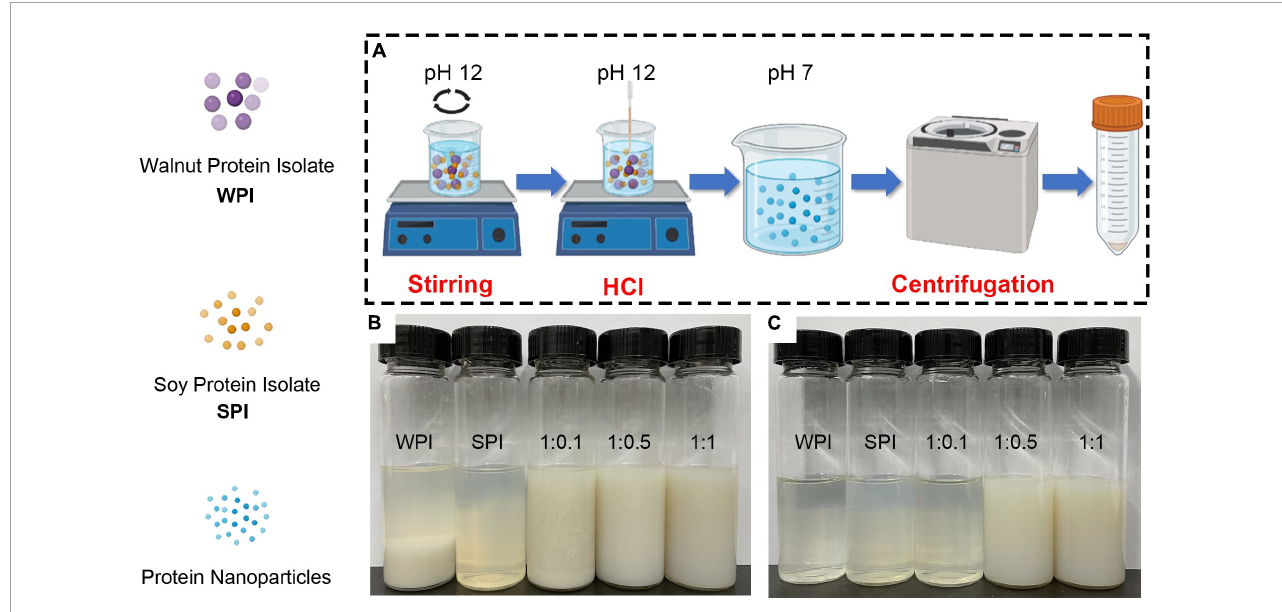
FIGURE1 (A) Schematic illustration of the pH-cycle technique for fabricating protein-based composite nanoparticles with hydrophobic WPI and hydrophilic SPI. (B) Photographs of protein solutions and composite nanoparticles after the pH-cycle treatment. (C) Photographs of sample supernatants by centrifuging at 10,000 × g and 4 ◦ C for 20 min (1:0.1, 1:0.5, 1:1 represents walnut protein and soy protein isolate at the ratio of WPI:SPI = 1:0.1, 1:0.5, 1:1, respectively).